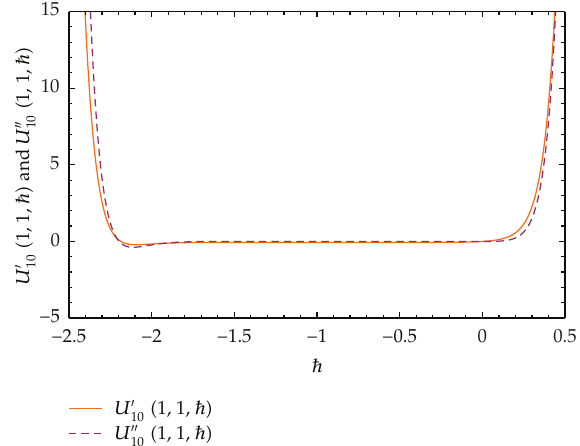
Figure 6: The ℎ curves of 𝑈 󸀠 10 (1,1, ℎ) and 𝑈 󸀠󸀠 10 (1,1, ℎ) for C - C column.